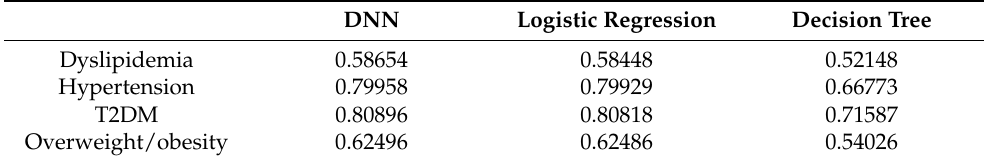
Table 5. Results of accuracy analysis for classification models: DNN, logistic regression and deci- sion tree.